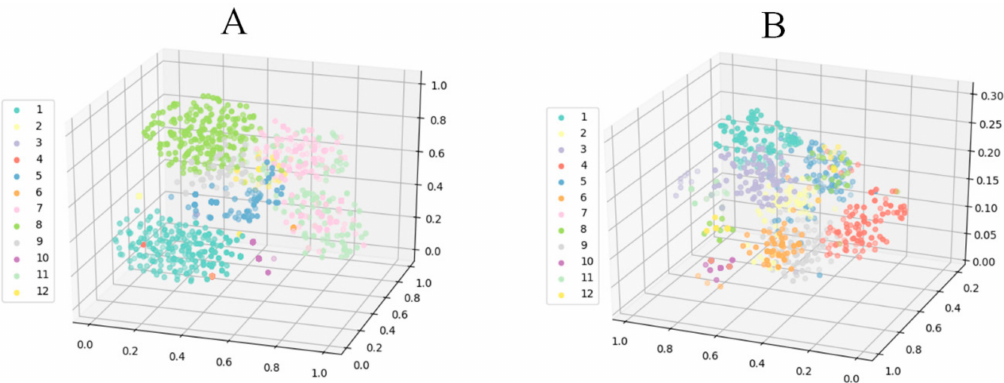
Figure 12. Feature visualization via t-SNE (t-distributed stochastic neighbor embedding). Left shows the feature representations for the last fully connected layer of attention-based multi-scale CNN model for evaluation ( A ). Right shows the feature representations for evaluation ( B